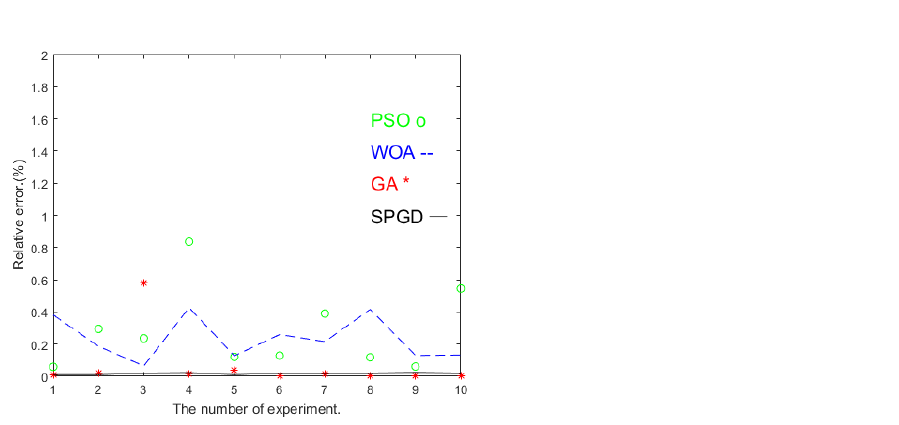
Figure 11. Comparison of relative error of different methods in 10 experiments when µ = 0.15.